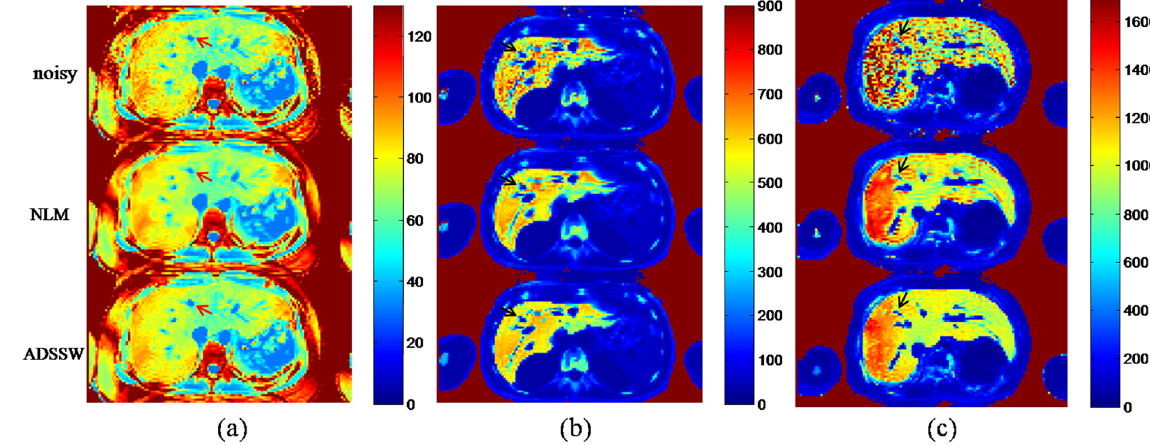
Figure 7. R2 * mappings generated from the original, NLM-, and ADSSW-filtered in vivo liver images of three subjects with ( a ) normal, ( b ) moderate, and ( c ) severe